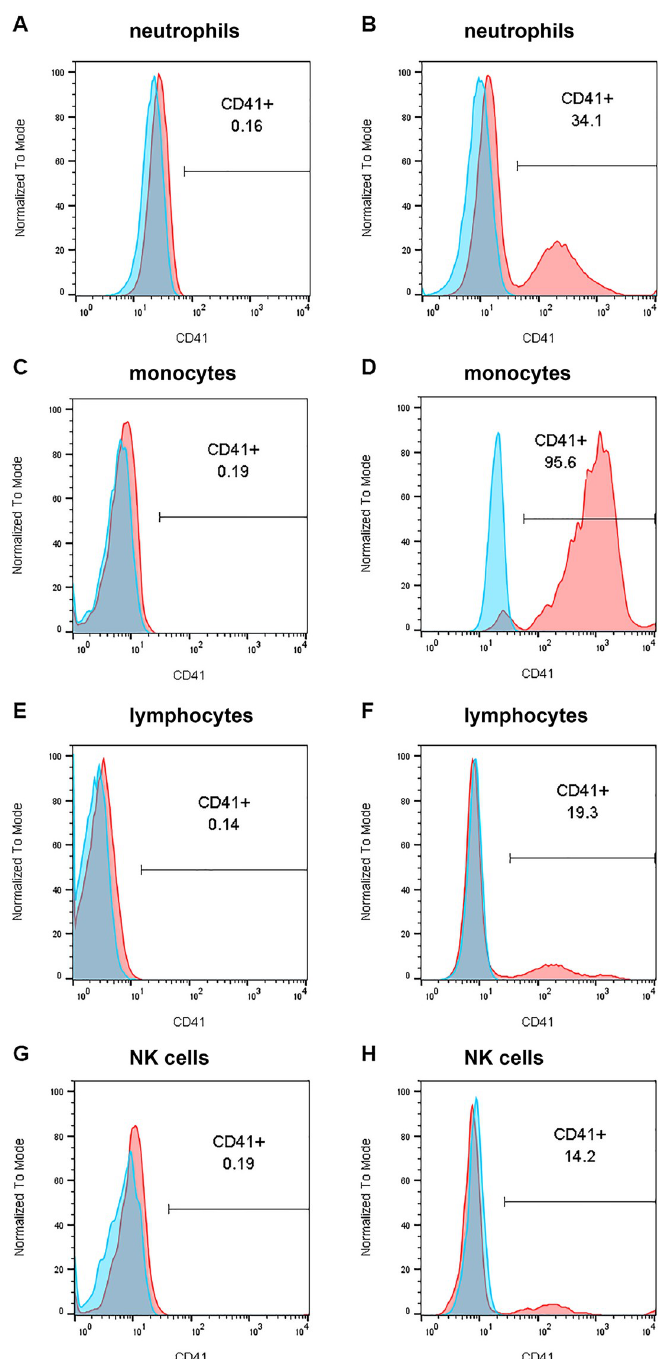
Fig 1. Examples of flow cytometry histogram for blood leukocyte CD41 at V2. Red, CD41; blue, isotype control. A and B) Neutrophils. C and D) Monocytes. E and F) Lymphocytes. G and H) Natural killer (NK) cells. A, C, E, and G) Subject No. 8 with 0.2% CD41-positive neutrophils, monocytes, and NK cells; 0.1% CD41-positive lymphocytes; and PEC = 0/HPF. B, D, F, and H) Subject No. 13 with 34% CD41-positive neutrophils, 96% CD41-positive monocytes, 19% CD41-positive lymphocytes, 14% CD41-positive NK cells, and PEC = 85/HPF. Note that CD41+ cells in B, D, F, and H form a distinct peak to the right well separated from the CD41- cells to the left that overlay cells stained with non-immune control immunoglobulin. The location of the marker was set in the “valley” between the negative and positive peaks or subpopulations, as described in Methods section.